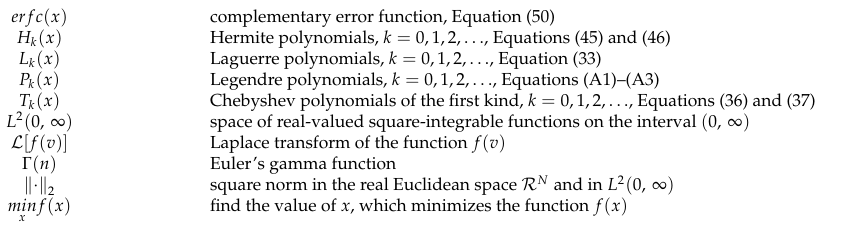
λ GCV − g of the relaxation spectrum models from Example 2; the elements K (cid:104) (cid:105) MPa · s 1/2